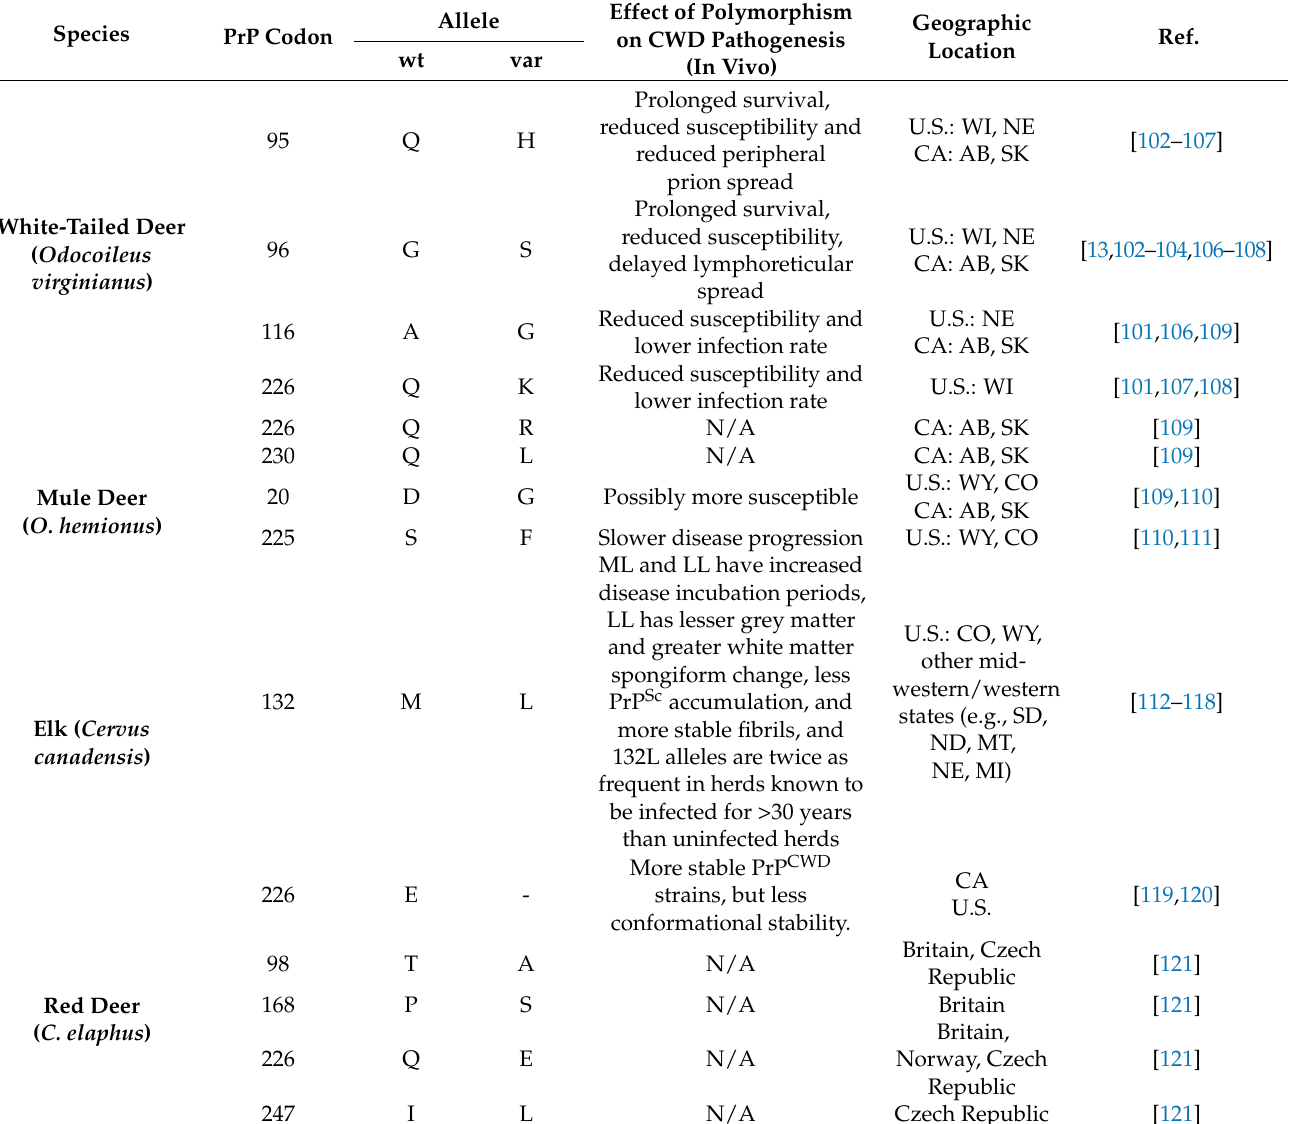
Table 1. Cervid prion protein polymorphisms reported to